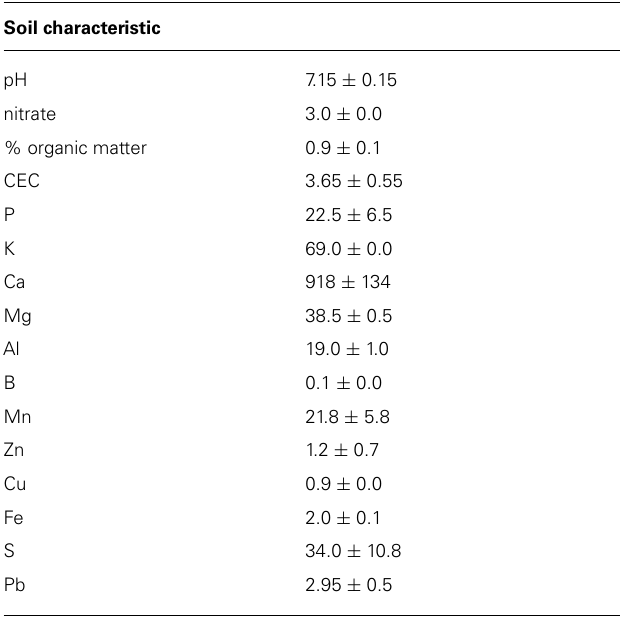
Table 1 | Characteristics of sterilized soil mixture (mean ± 1 SE, n = 2). Soil